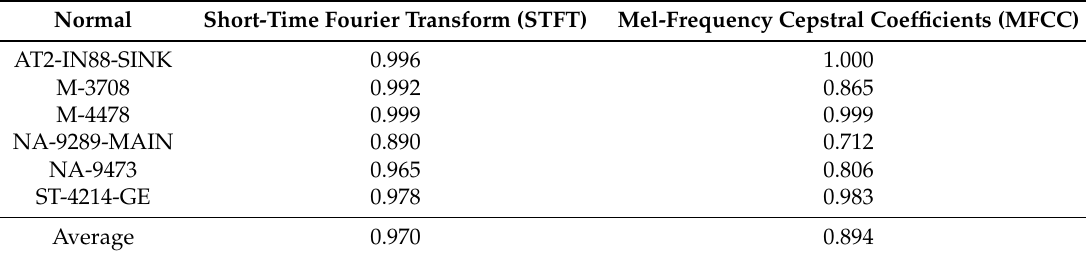
Table 5. Area Under the Curve (AUC) matrix of anomaly detection using Mel-Frequency Cepstral Coefficients (MFCC) feature